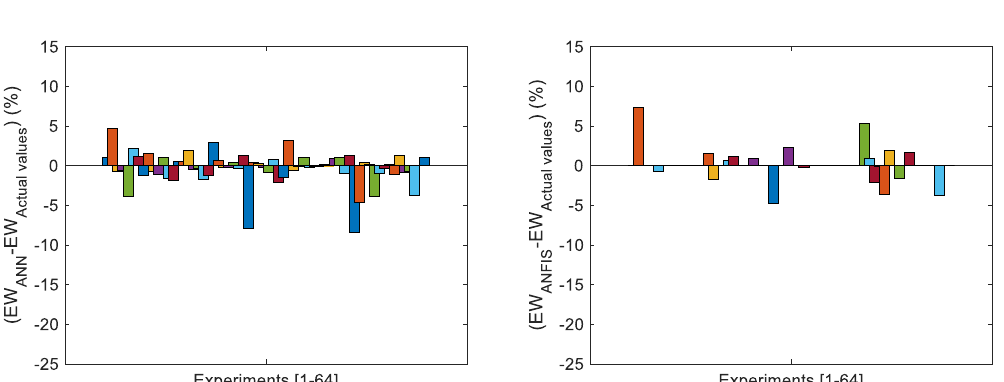
Figure 34. Difference between the actual values and those provided by the (Regression, ANN 3-5-2-1 , and ANFIS,) models for modeling EW (%) (Type 2 function). The data for obtaining these graphs have been taken from Ref. [61]).